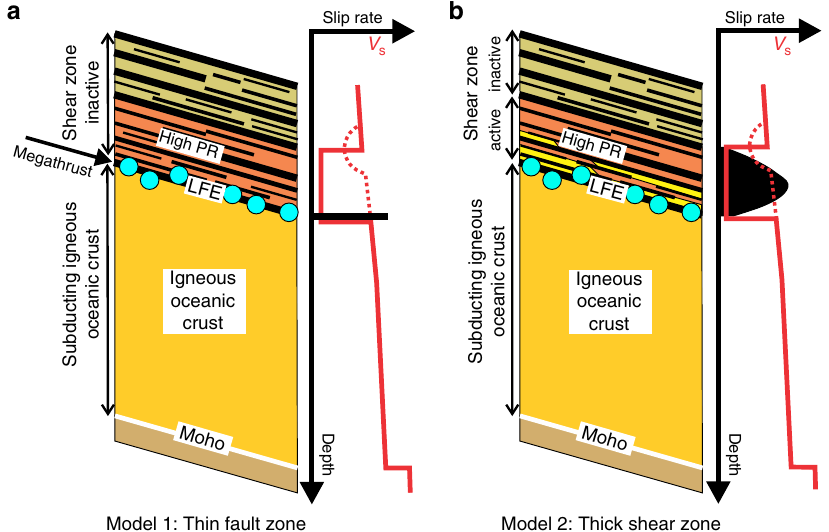
Fig. 5 Alternative models of the inter-plate boundary beneath southern Vancouver Island in the region of slow slip. a Model 1: All slow slip on the inter- plate boundary coincides with the low-frequency earthquakes (LFE), implying that the plate boundary is relatively thin and that the overlying E re fl ectors represent an inactive shear zone. The region of high Poisson ’ s ratio (PR) lies within the overriding plate. b Model 2: Slow slip is vertically distributed within the lower part of the re fl ective shear zone, likely corresponding to the region where Poisson ’ s ratio is elevated. The shear zone includes underthrust rocks from the overriding forearc (orange), which may be imbricated with basaltic rocks derived from the top of the descending oceanic crust (yellow). Seismic velocities beneath southern Vancouver Island are too large to be consistent with a large amount of subducted metasedimentary rock, and the lithology in the shear zone here is largely ma fi c. Schematic vertical variations in S wave velocity inferred from teleseismic data and tomography are shown by the solid red and dashed red lines respectively; the latter is not correlated with the high Poisson ’ s ratio ultra-low S wave velocity zone (Supplementary Fig.